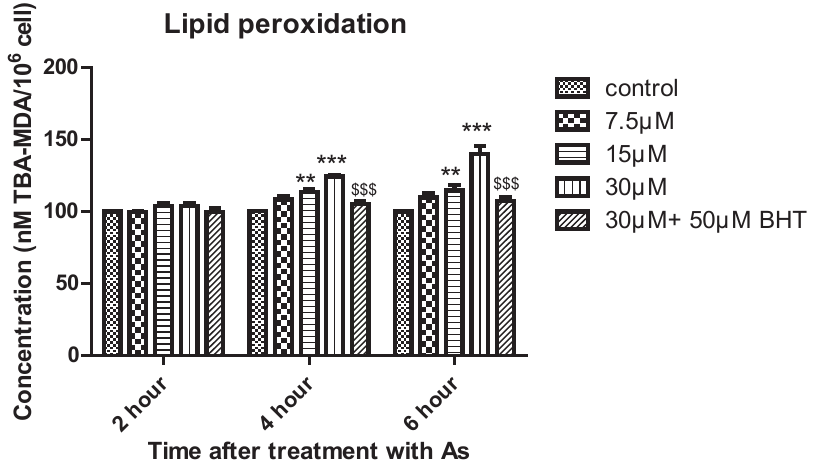
Figure 4: Induction of lipid peroxidation in human lymphocyte after incubation with As for 6 h. At 4 and 6 h following treatment, two higher concentration of As (15 and 30 µM) significantly (P < 0.05) increased MDA concentrations in human lymphocytes. BHT prevented As-induced increase in MDA levels. ** (P < 0.01) and *** (P < 0.001): significant difference compared to the control group. $$$: significant difference with 30 µM DBP.